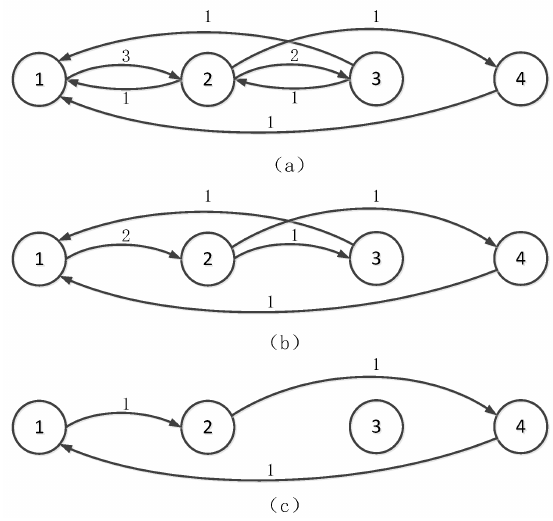
Figure 2. Directed graph of information interaction among nodes. ( a ) Initial message directed graph, ( b ) message directed graph after eliminating 2-ring, and ( c ) message directed graph after eliminating 3-ring